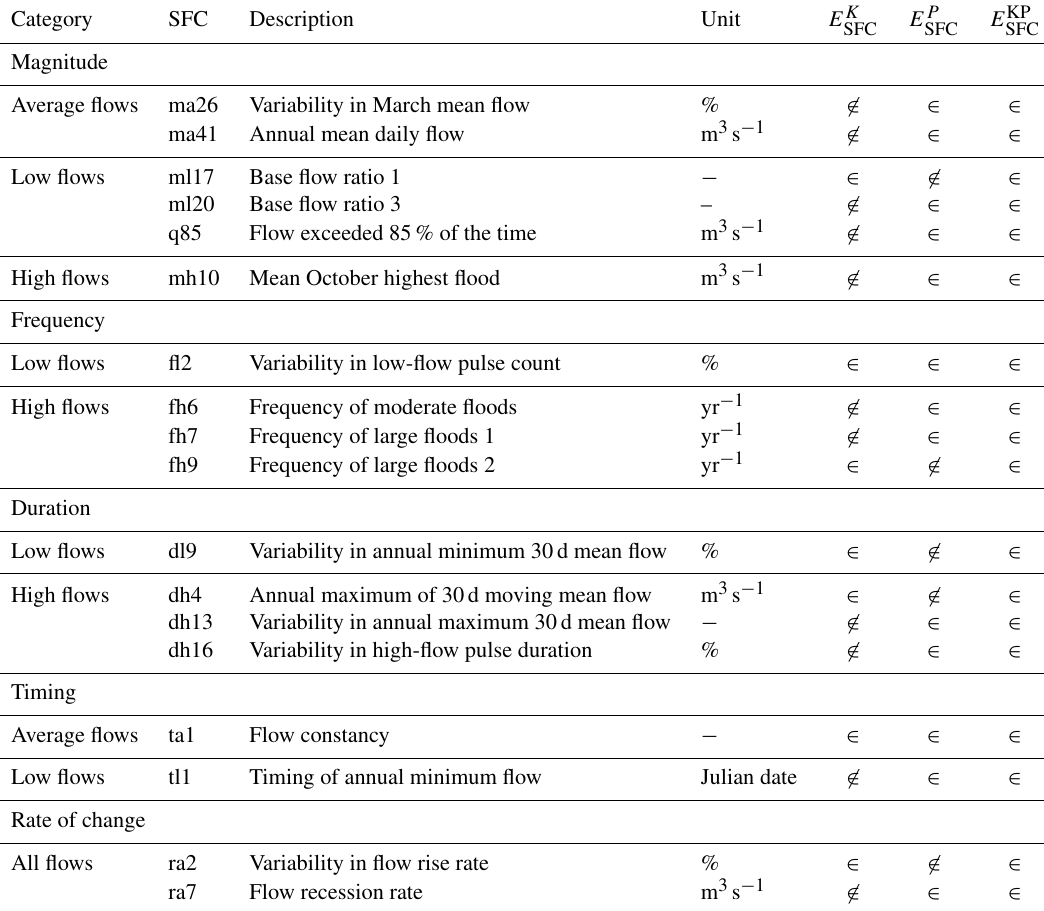
Table 1. List and description of the 18 selected streamflow characteristics. Detailed calculations for each SFC available in Table A2. The three last columns indicate whether a given SFC is included ( ∈ ) or not included ( (cid:54)∈ ) in Eq. (4) for the definition of each of the three tailored objective